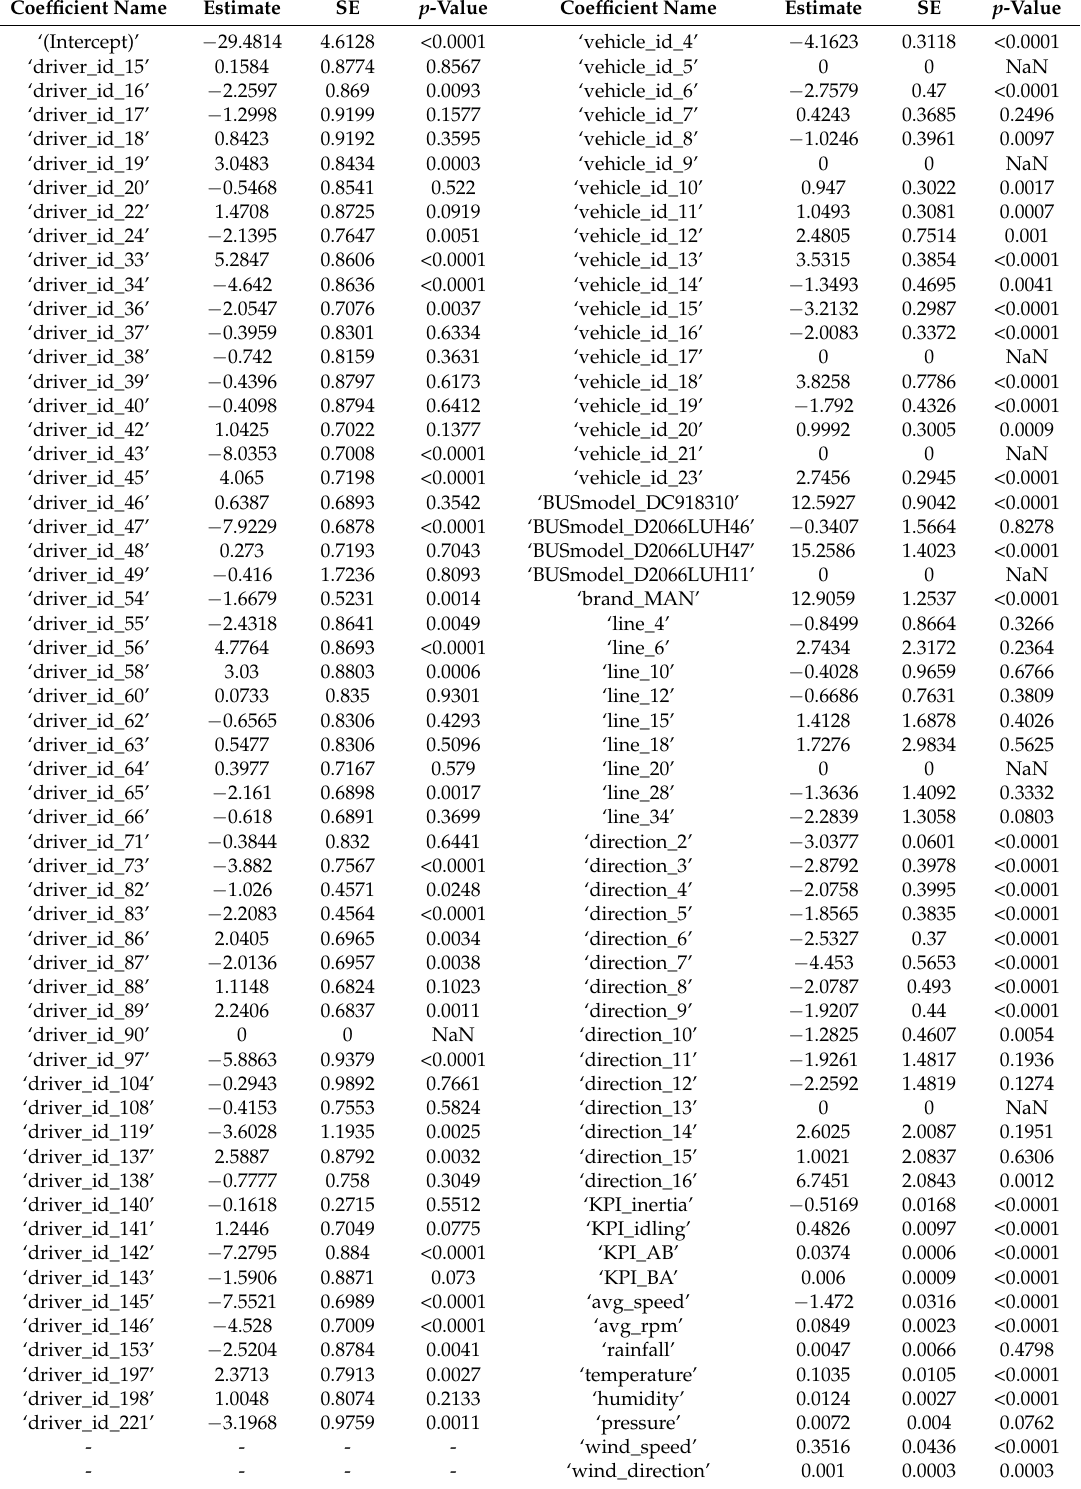
Table A1. Coefficient estimation for the modified linear